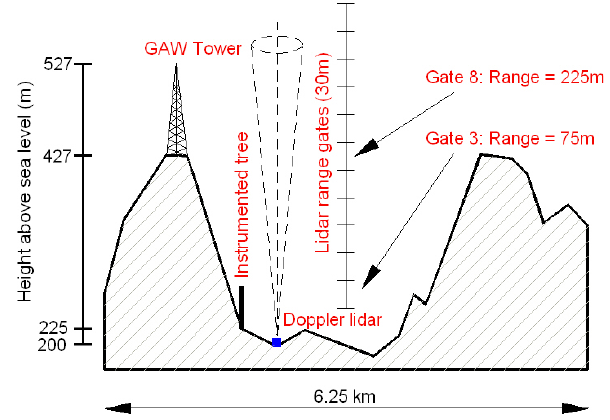
Fig. 2. A schematic cross section of the terrain around the lidar site from the NW (left) to the SE (right). Note the different vertical and horizontal scales and the location of the lidar with respect to the valley floor and the GAW tower. The location of the instrumented tree used for the in canopy measurements is also shown.